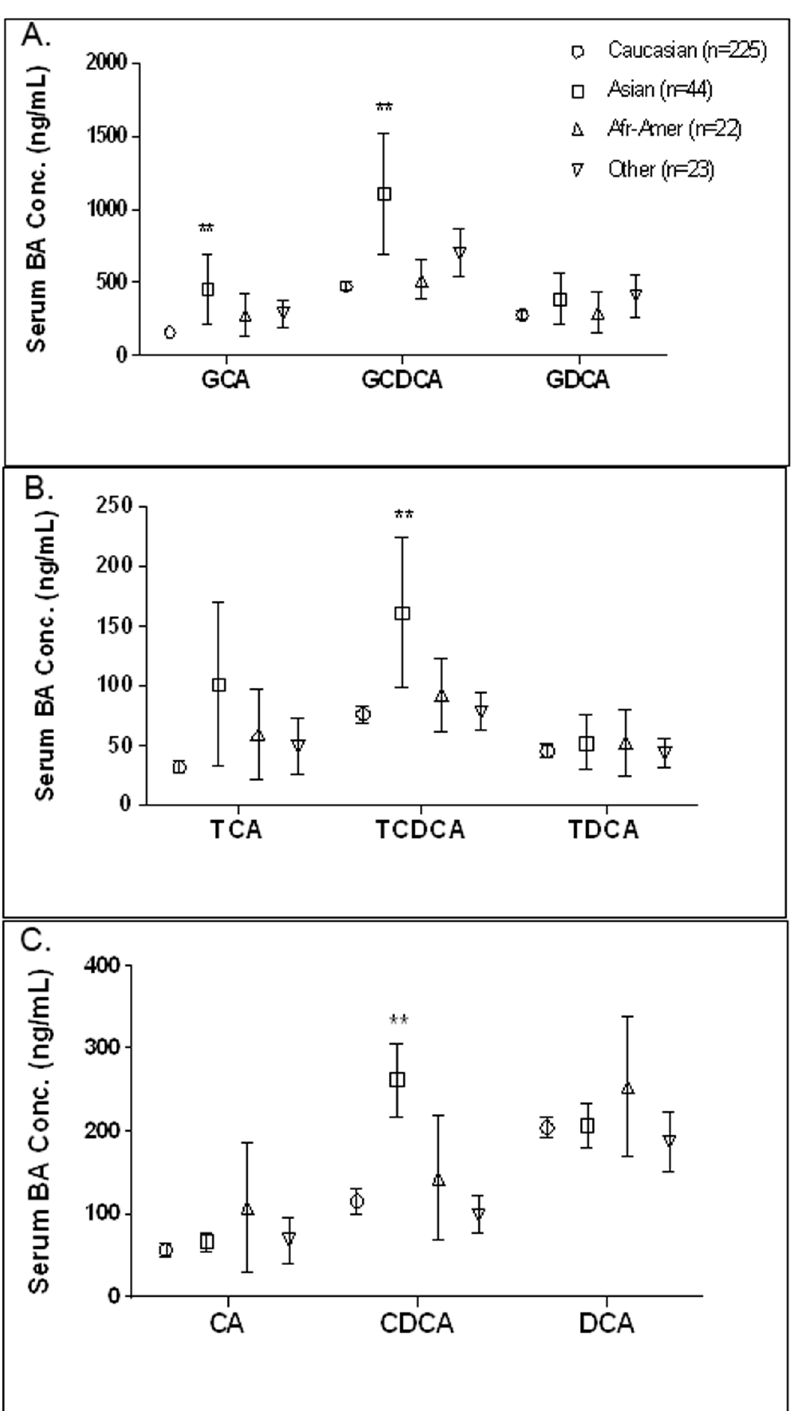
Fig 1. Influence of ethnicity on individual bile acid (IBA) concentrations in healthy subjects. Serum samples from healthy subjects were analyzed for glyco-conjugated bile acids (A), tauro-conjugated bile acids (B), and unconjugated bile acids (C). The values represent average concentrations ±